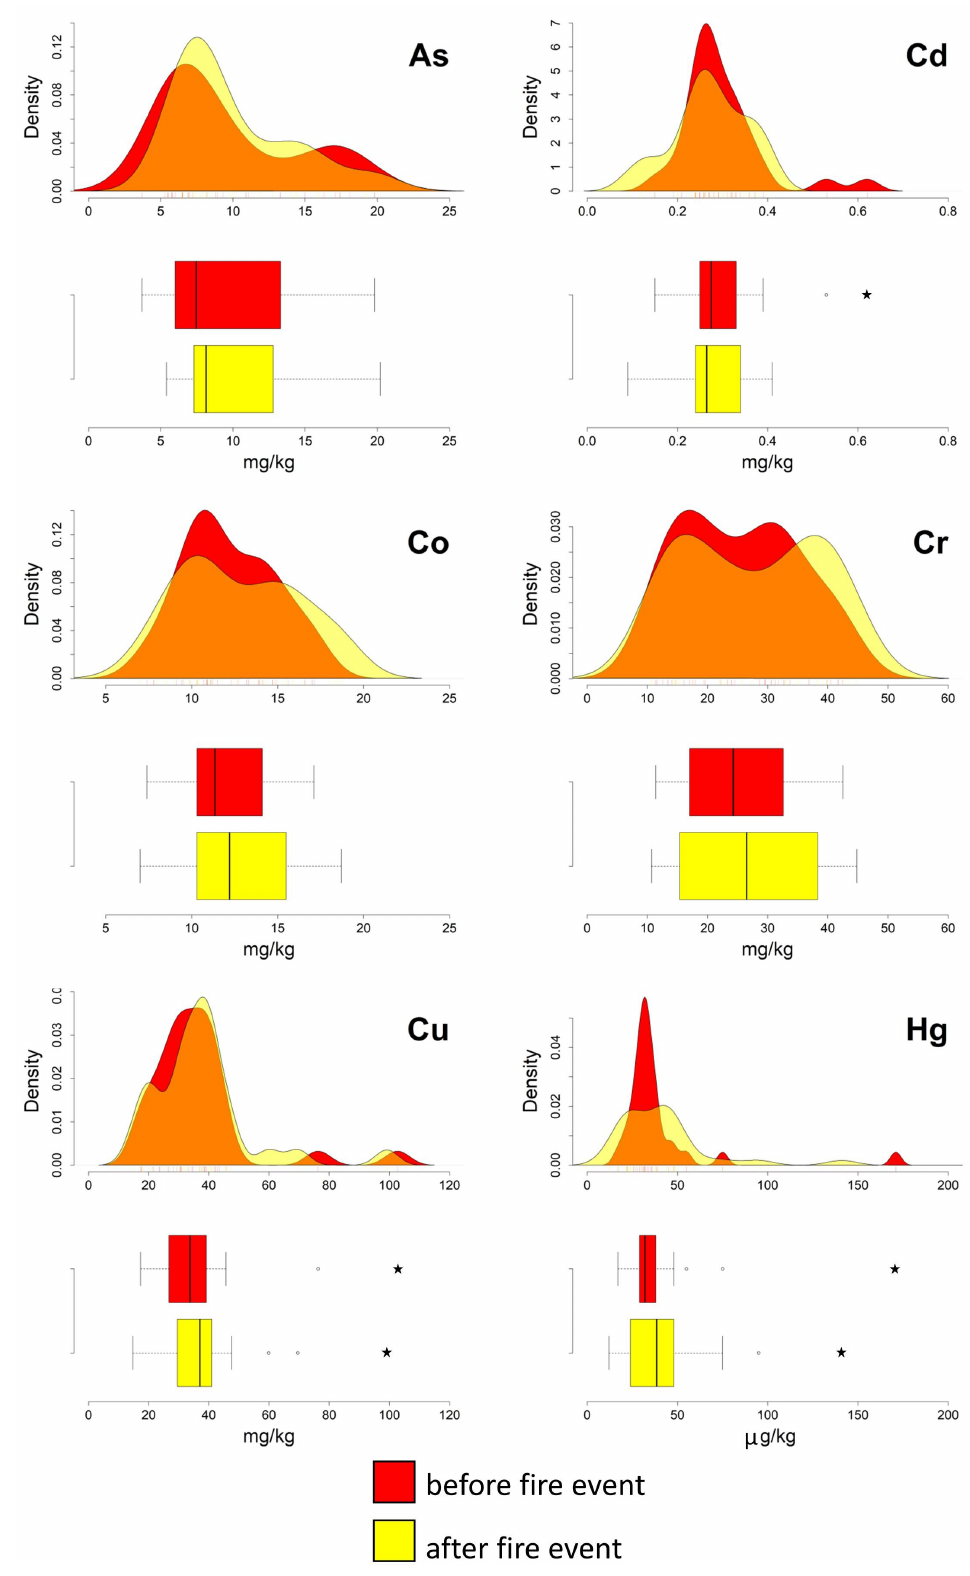
Figure 2. Figure 2. Ilside site. Boxplots and density curves of selected PTEs (As, Cd, Co, Cr, Cu, and Hg) in the soil before and after the fire event. Circles and pentagrams represent outliers and extreme values,